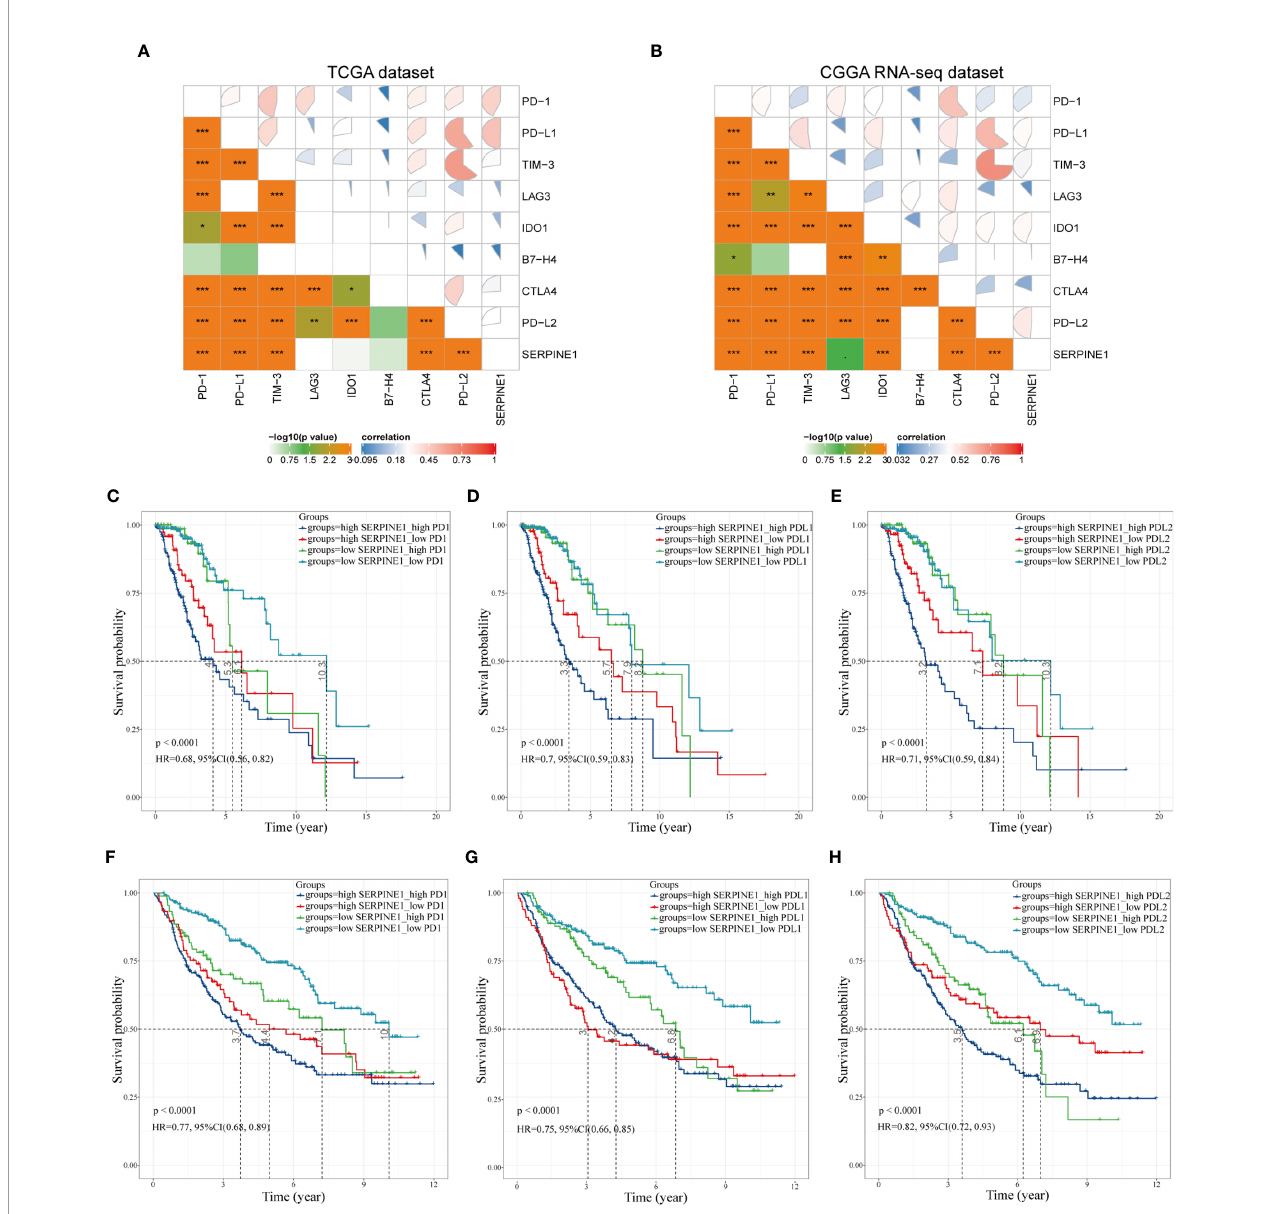
FIGURE 9 | Correlation analysis between SERPINE1 and immune checkpoints. (A, B) Correlation matrix plots of SERPINE1 and major immune checkpoints in the TCGA dataset and CGGA dataset. (C, F) Kaplan – Meier survival analysis in LGG patients strati fi ed by SERPINE1 and PD-1 expression. (D, G) Kaplan – Meier survival analysis in LGG patients strati fi ed by SERPINE1 and PD-L1 expression. (E, H) Kaplan – Meier survival analysis in LGG patients strati fi ed by SERPINE1 and PD-L2 expression. P-value < 0.05 was considered statistically signi fi cant. *p-value ≤ 0.05; **p-value ≤ 0.01; ***p-value ≤